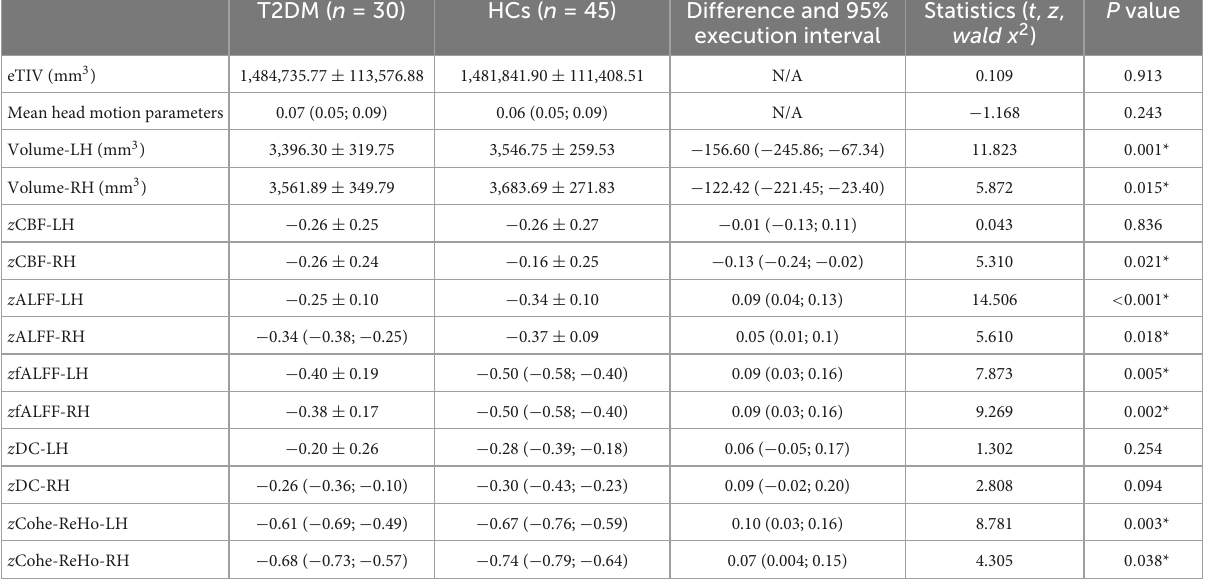
TABLE 3 Bilateral hippocampal imaging